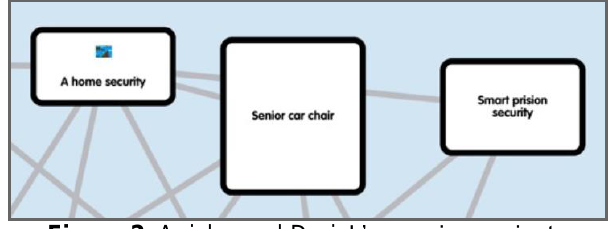
Figure 2. Anisha and Derick’s passion project